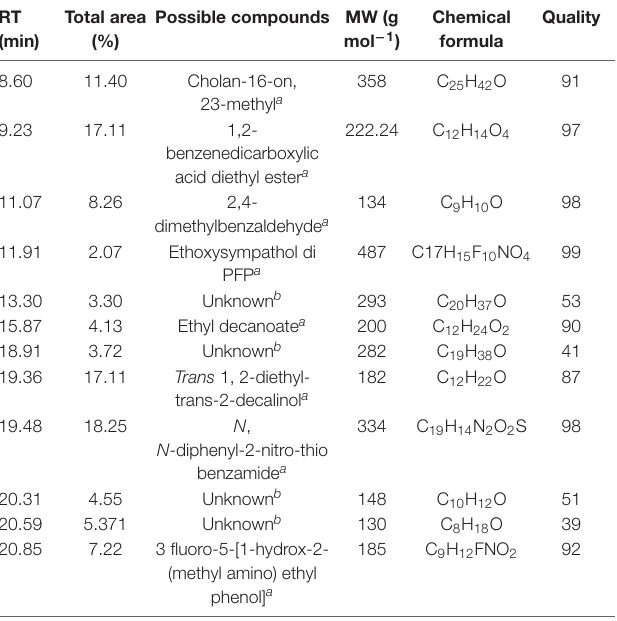
RT Total area Possible compounds MW (g (min) (%)